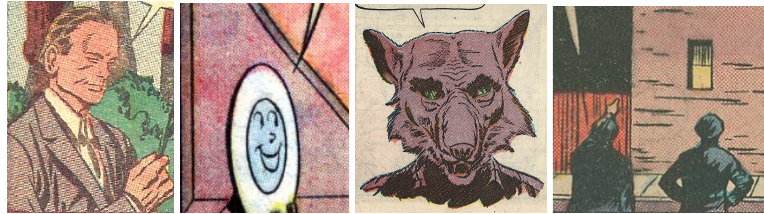
Figure 5. Examples of each annotated character class in the dataset DCM772. From left to right: human-like, object-like, animal-like and